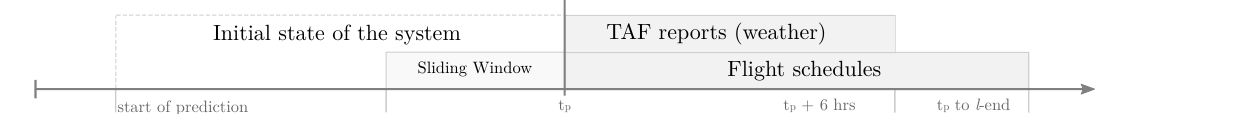
Figure 9. The width of the time horizons of the supporting features defines the maximum prediction.